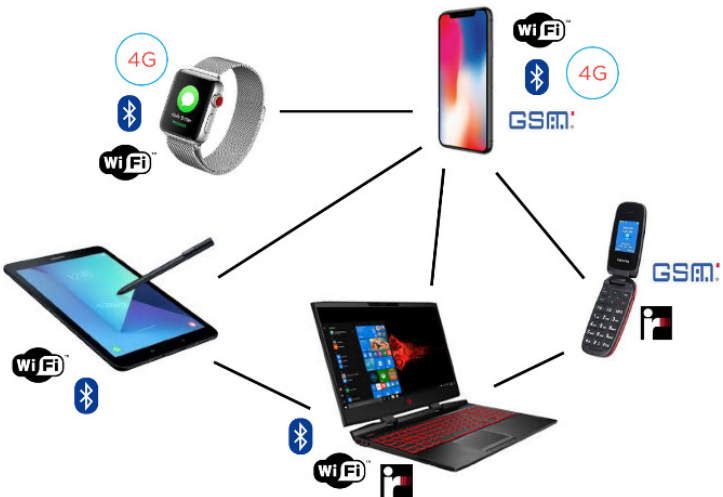
Figure 1. Example of multi-interface network composed of heterogeneous devices connected by means of different